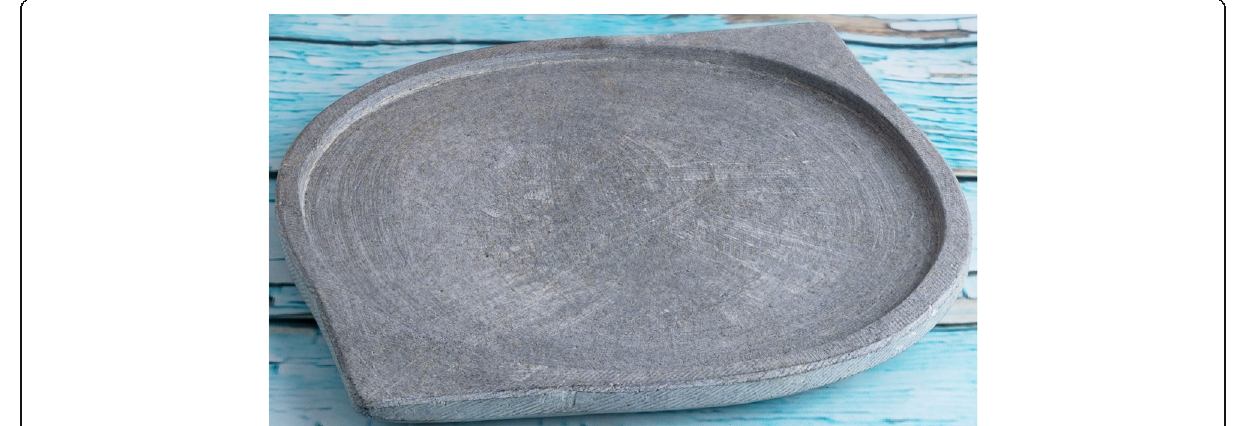
Fig. 6 The soapstone pan used for making dosa , neer dosa , roti , and